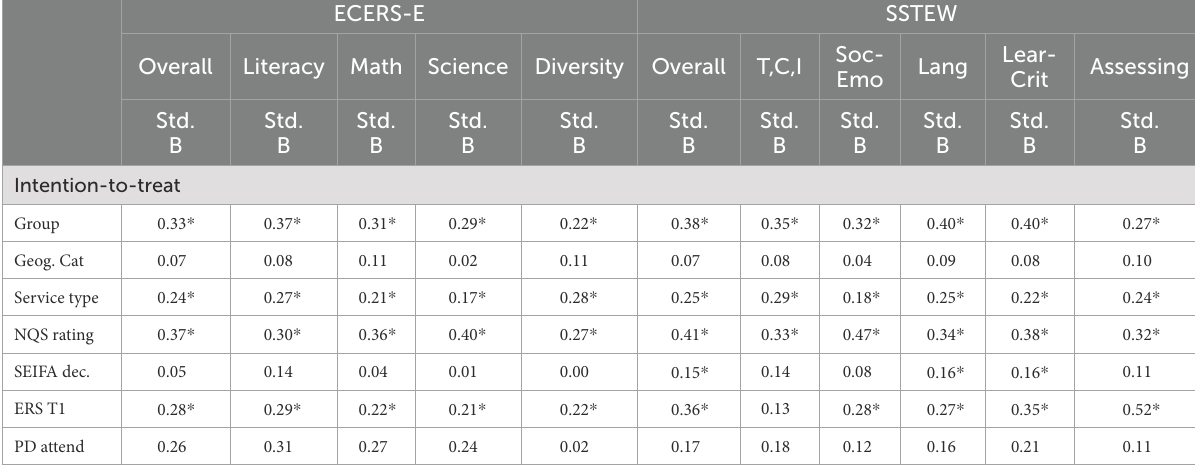
TABLE 5 Standardised beta weights for predictors of post-intervention ECERS-E and SSTEW ratings, pre-protocol.